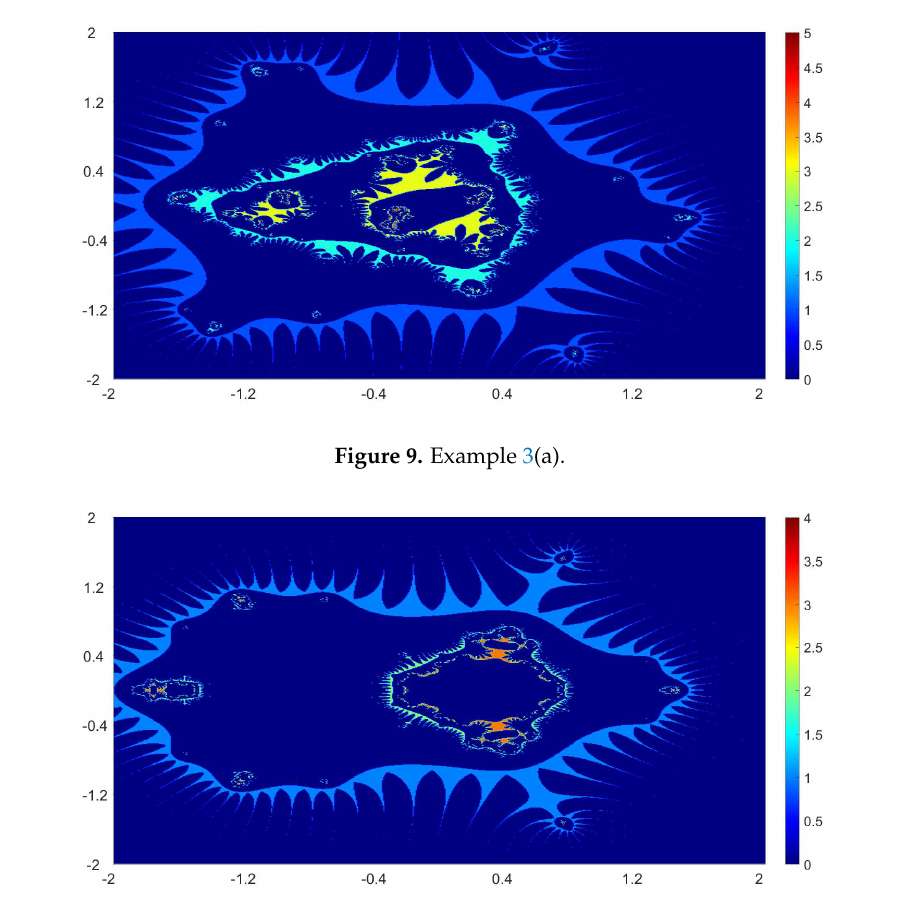
Figure 10. Example